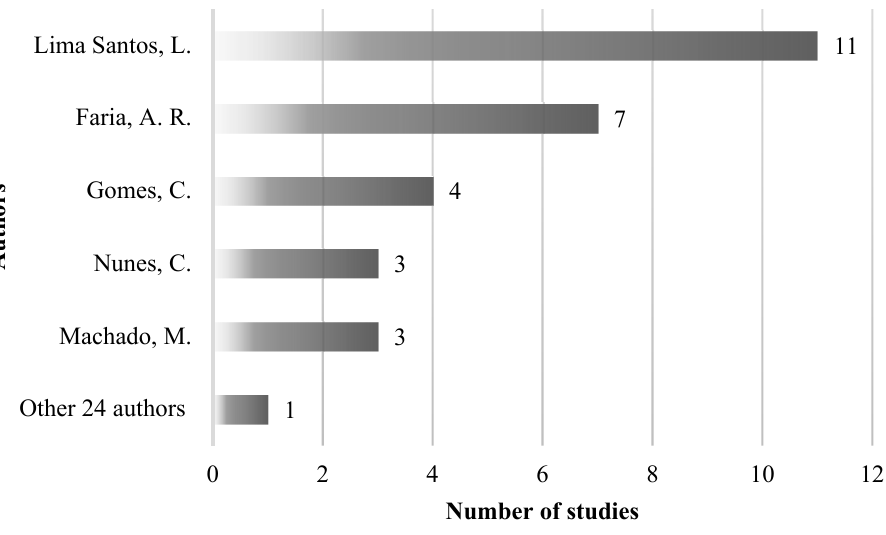
Figure 9. First authors ranking.